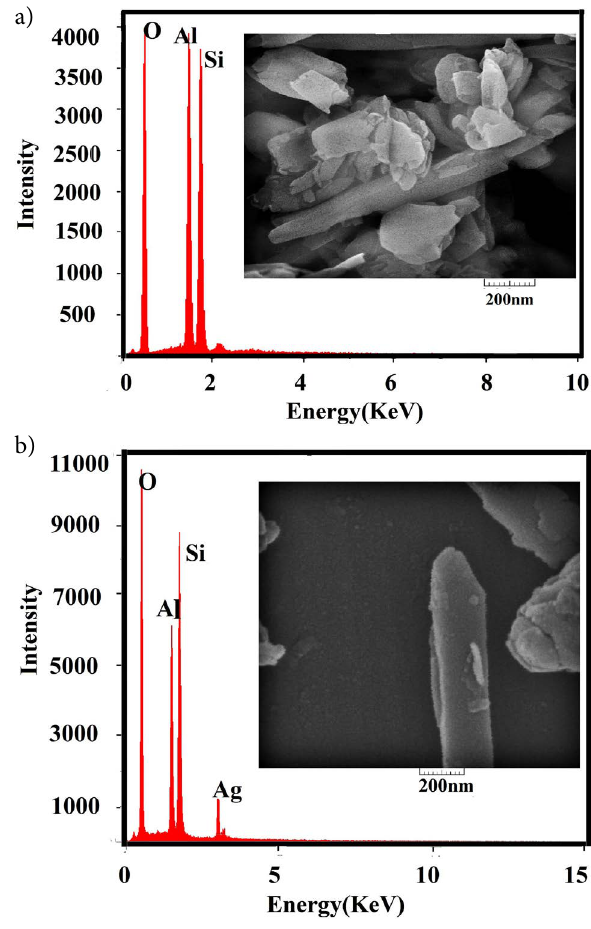
Fig 5. EDX spectra and FE-SEM images of (a) HNTs and (b) Ag/